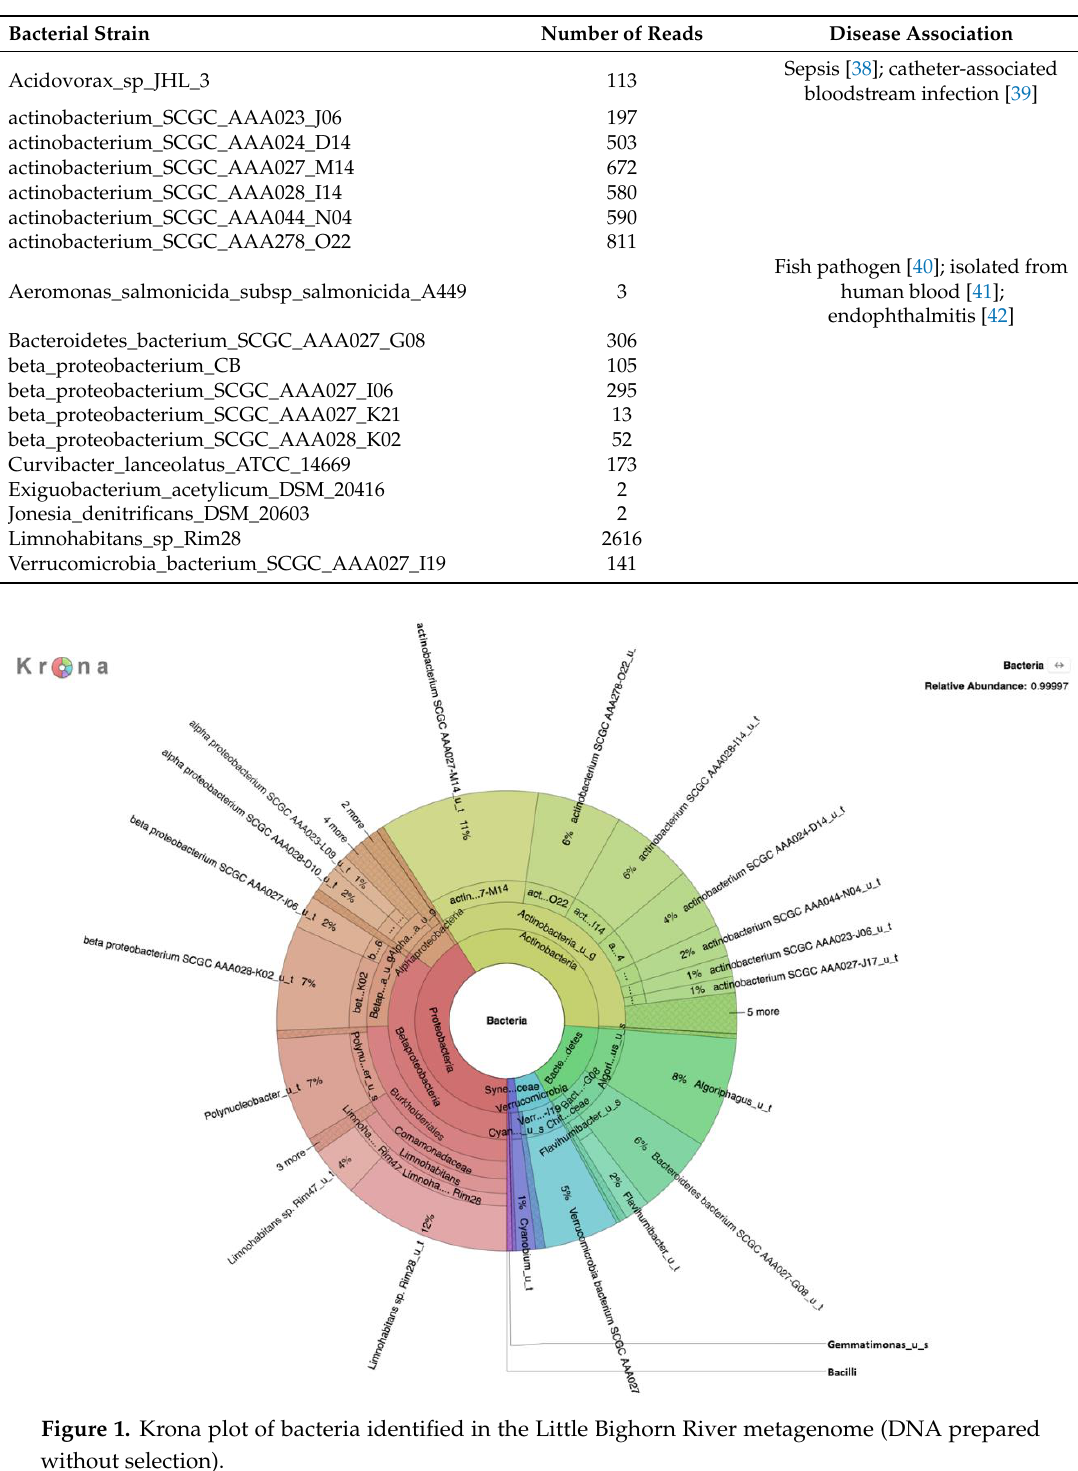
Table 3. Bacterial community identified in the Little Bighorn River metagenome (DNA prepared without selection).